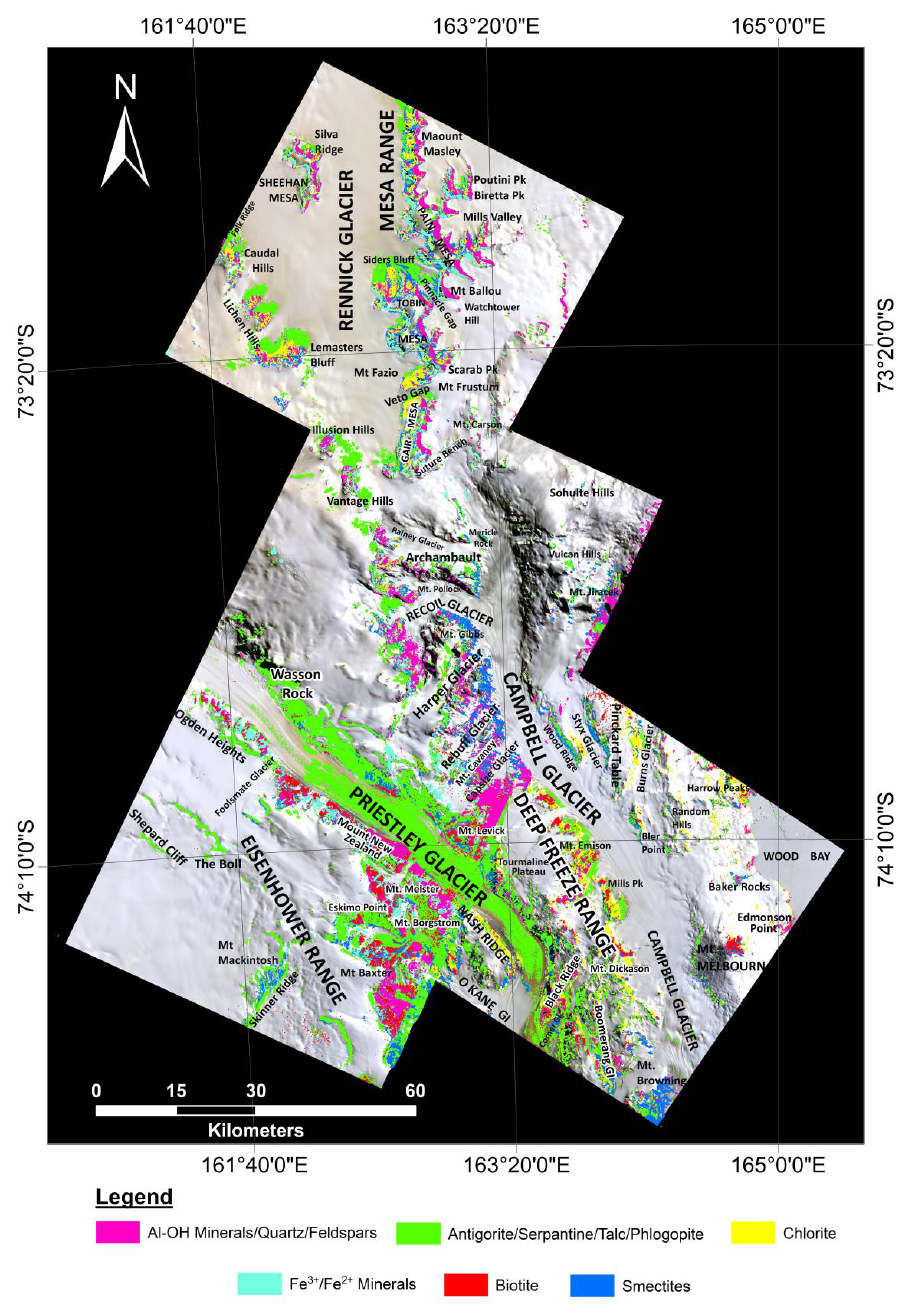
Figure 15. Mosaic phyllosilicates image-map of the Mesa Range, Campbell and Priestley Glaciers derived from VNIR+SWIR and TIR bands of ASTER. The use of “/” means as “and” for mineral